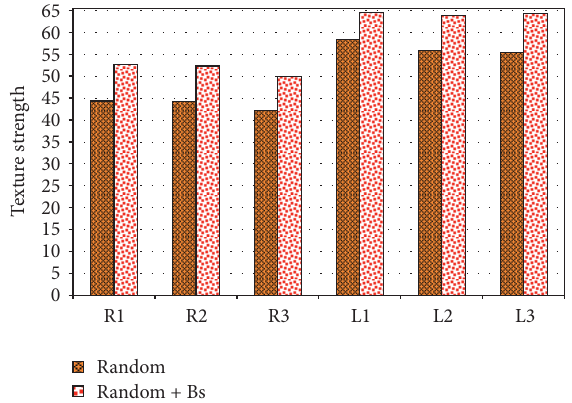
Figure 6: Texture strength of random (random + Bs) texture com- ponent.